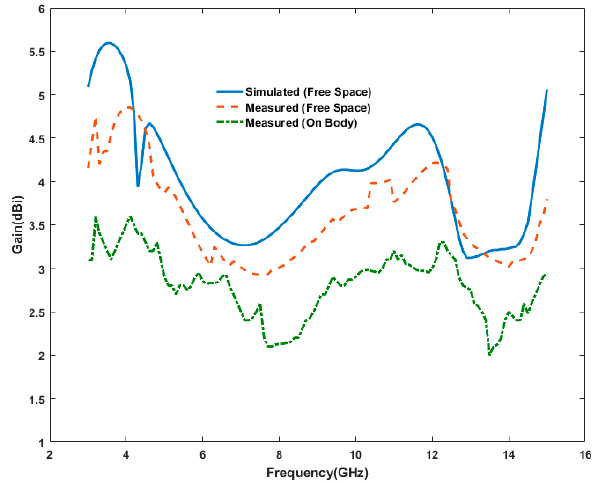
Figure 11. Simulated and measured gain performance.